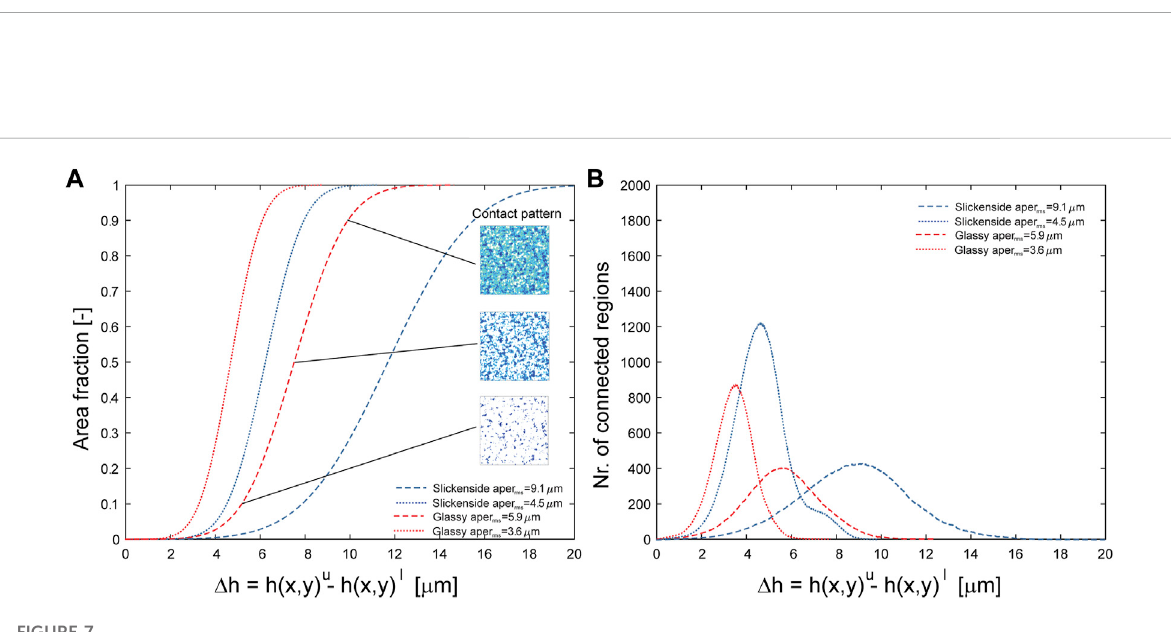
FIGURE 7 (A) Area fraction as a function of the aperture Δ h between the upper and lower fracture surfaces for slickenside and glassy fracture types with different congruence aper rms . The area fraction corresponds approximately to the area formed by successive fracture closure where the aperture corresponds to the displacement. The inserted images correspond to the expected contact pattern at different stages during fracture closure. (B) Number of contact regions as a function of aperture Δ h between the upper and lower fracture surface for slickenside and glassy fracture types with different congruency aper rms